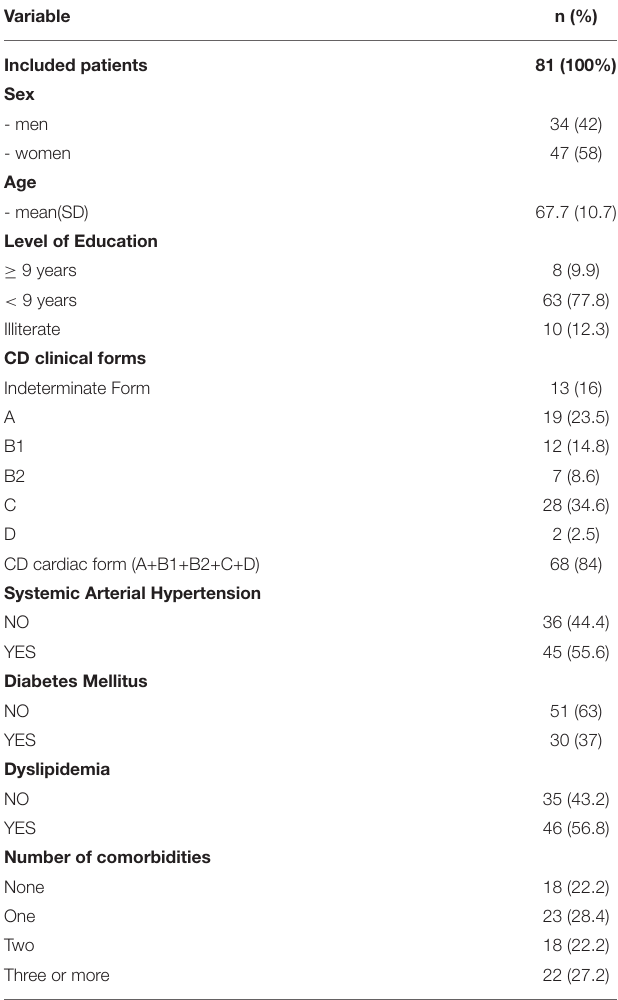
TABLE 1 | Demographics and clinical characteristics of CD patients admitted to the INI-Fiocruz hospital ( n = 81).